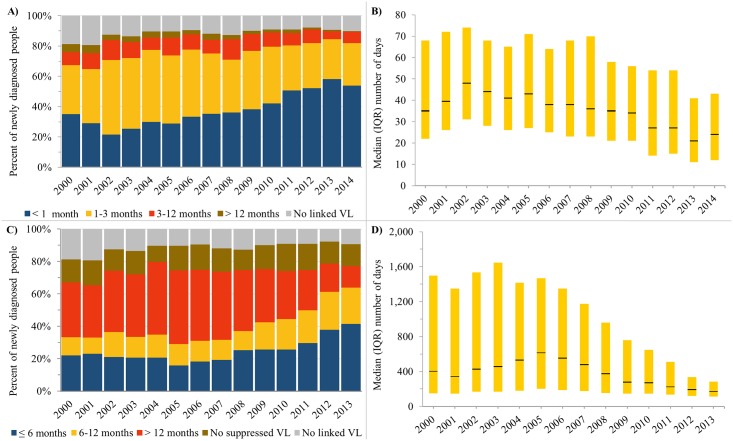
Trends in time from HIV diagnosis to linkage to care and viral suppression among individuals newly diagnosed with HIV in Ontario, 2000-2013/2014.A) Percent of newly diagnosed individuals who linked to care within a certain number of months after HIV diagnosis. B) Median (IQR) number of days from HIV diagnosis to linkage to care. C) Percent of newly diagnosed individuals who achieved viral suppression within a certain number of months after HIV diagnosis. D) Median (IQR) number of days for HIV diagnosis to viral suppression. In Fig B and D, yellow bar indicates interquartile range and black line indicates median.